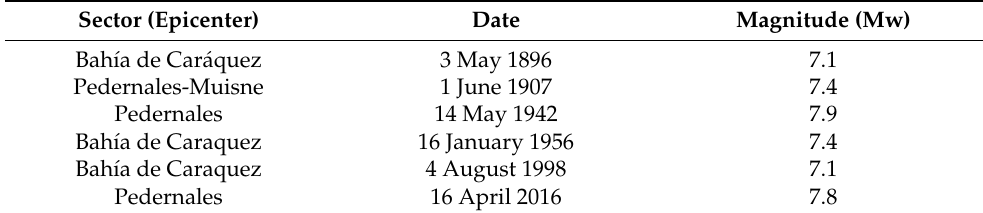
Table 1. Seismic subduction events in the Manabi Province